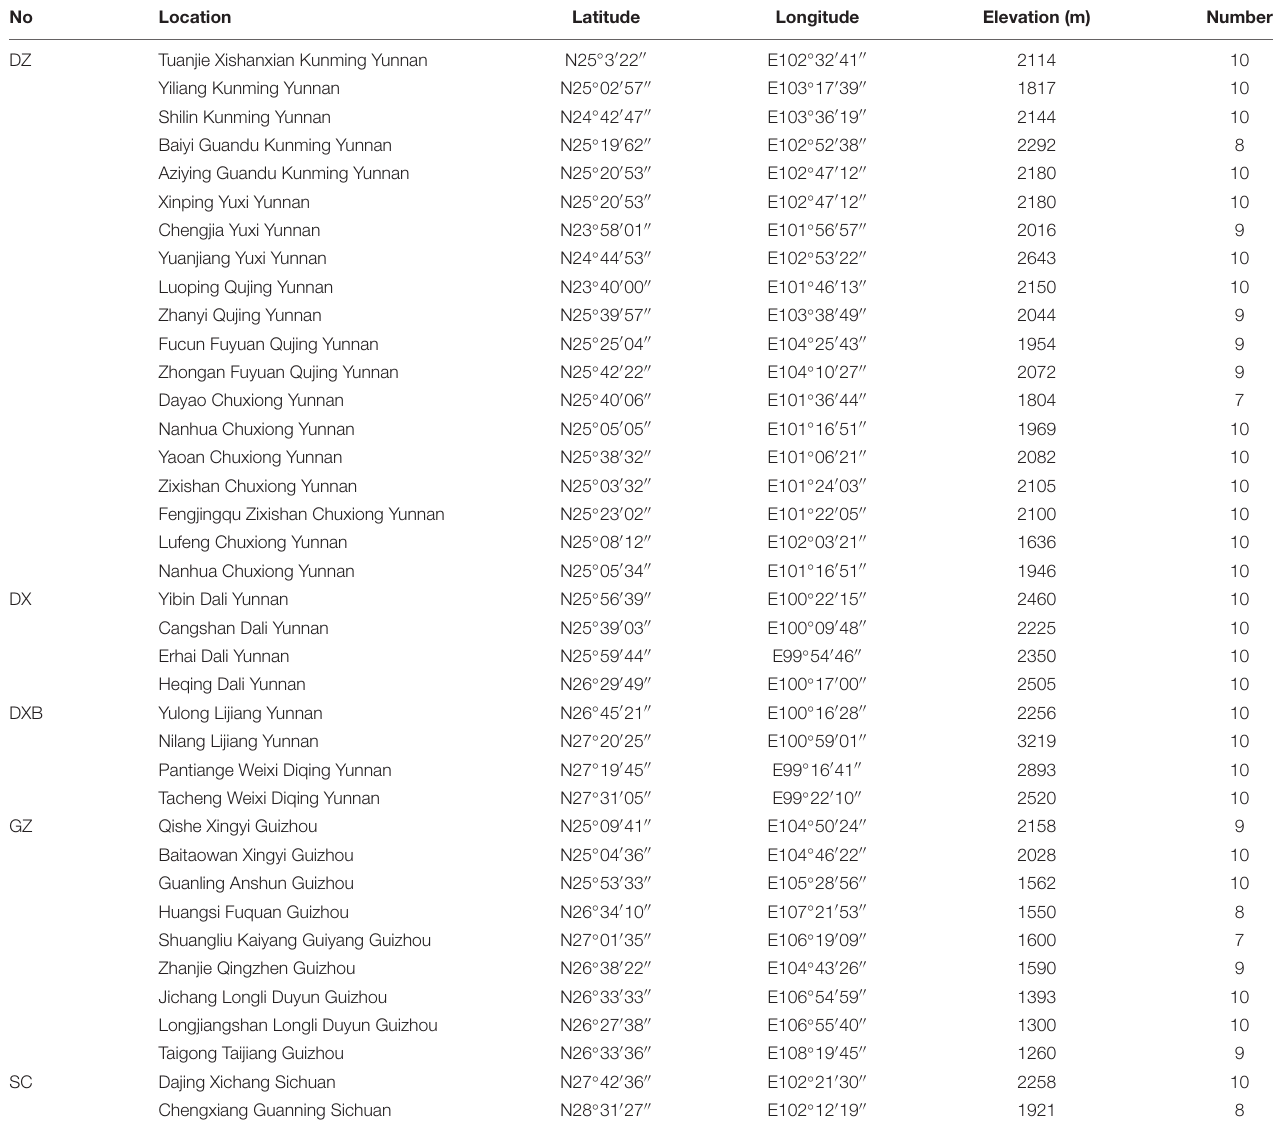
TABLE 1 | The detail information of G. rigescens